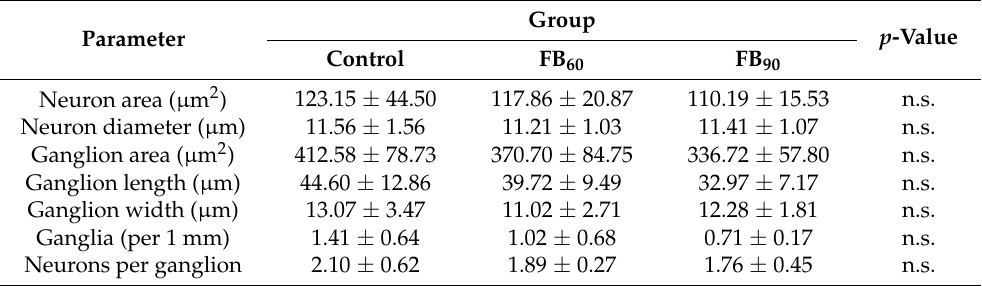
Table 3. Effect of the fumonisins intoxication on the morphology of the rat duodenal submucosal plexus (mean ±